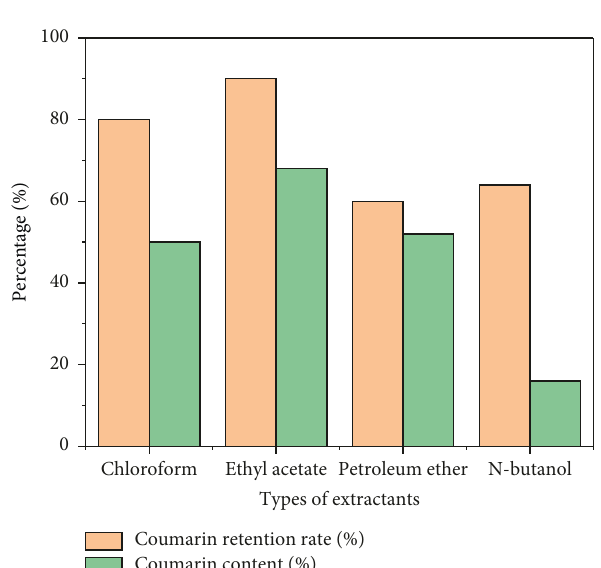
Figure 4: Effects of different extraction solvents on liquid-liquid extraction.